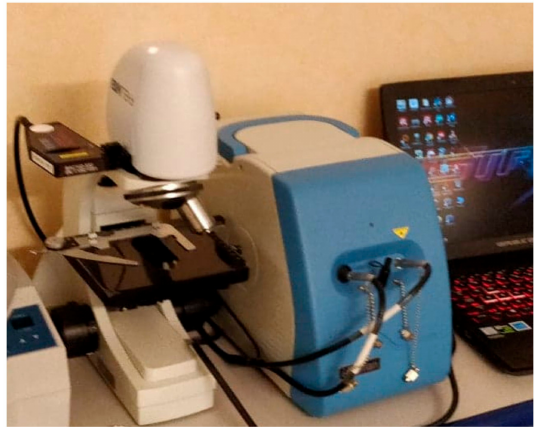
Figure 1. The Raman setup used in this study. The picture shows the portable Raman spectrometer coupled with a